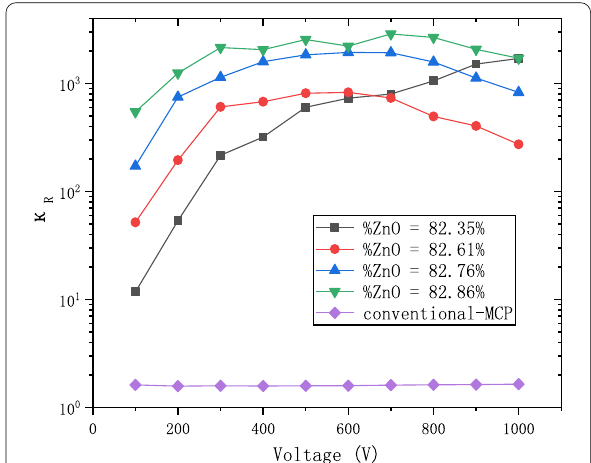
Fig. 8 The K R with the voltage diagram at the different ratio of AZO-ALD-MCP